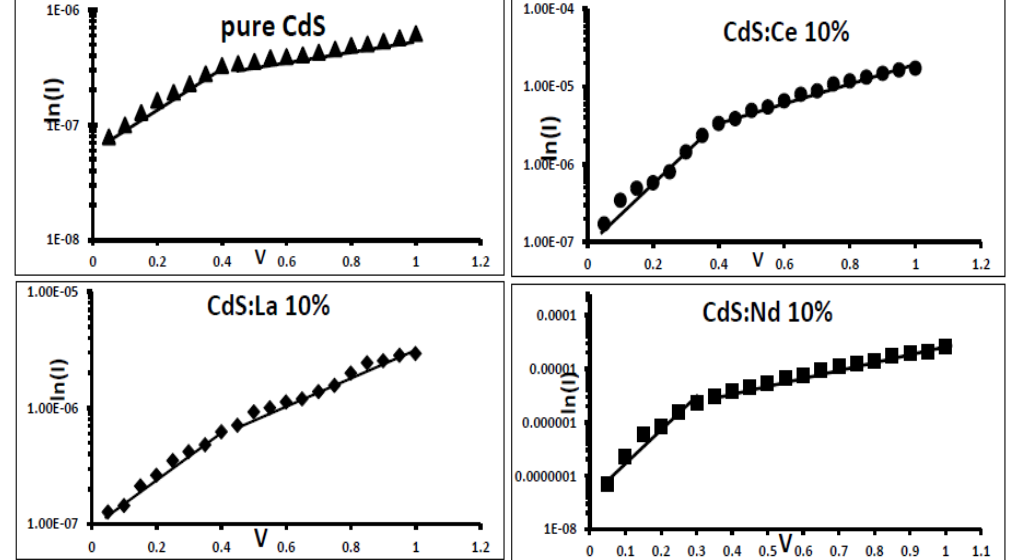
Fig. 7: Variation ln(I) VS Voltage under forward bias in dark for CdS and (Ce, La and Nd) doped CdS at 10